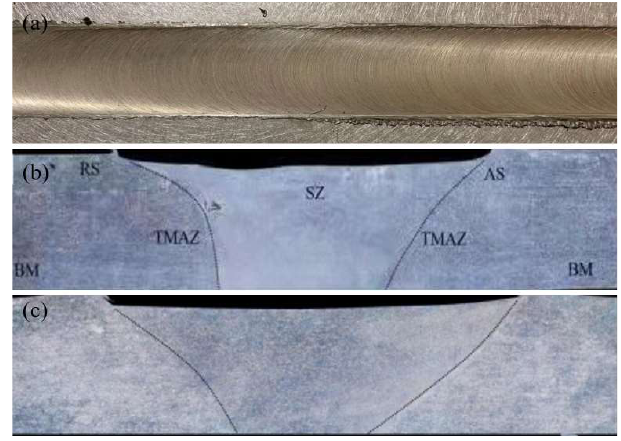
Figure 2. Macrograph of the FSW weld: ( a ) surface appearance of weld; ( b ) transverse cross-section of double-sided FSW sample; ( c ) transverse cross-section of conventional FSW sample.